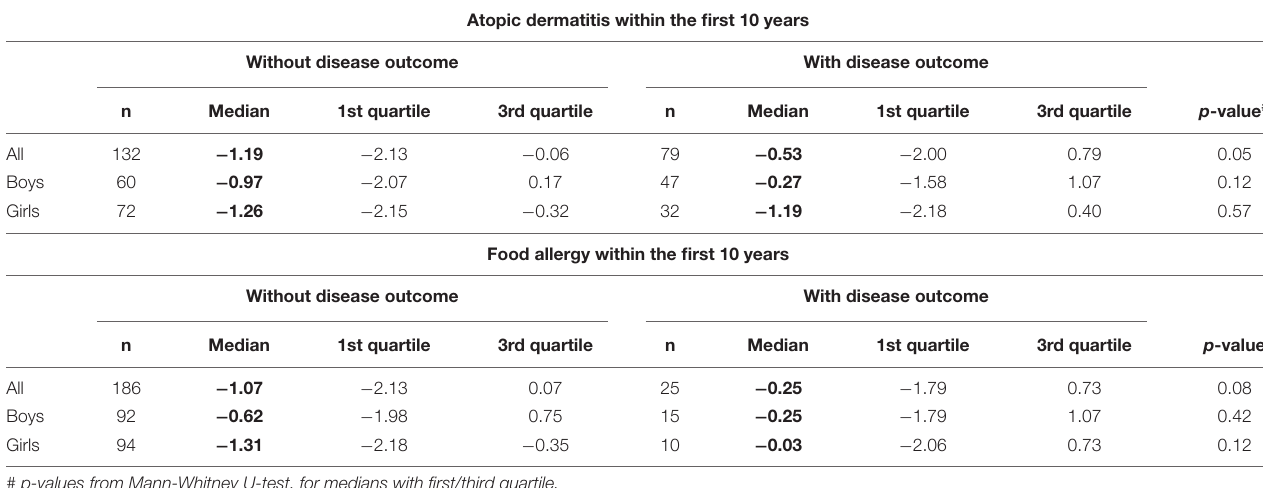
TABLE 4 | C-DII and atopic outcomes.